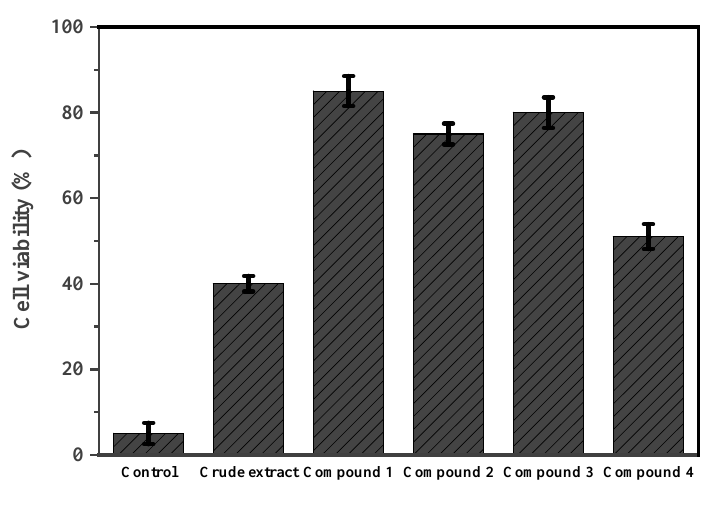
Figure 9. The MTT cytotoxic activity results for tested pure compounds and the crude extract of A. tubingensis (NA103) against L5178Y cell lines. Error bars represent standard error of the means ( n = 3).